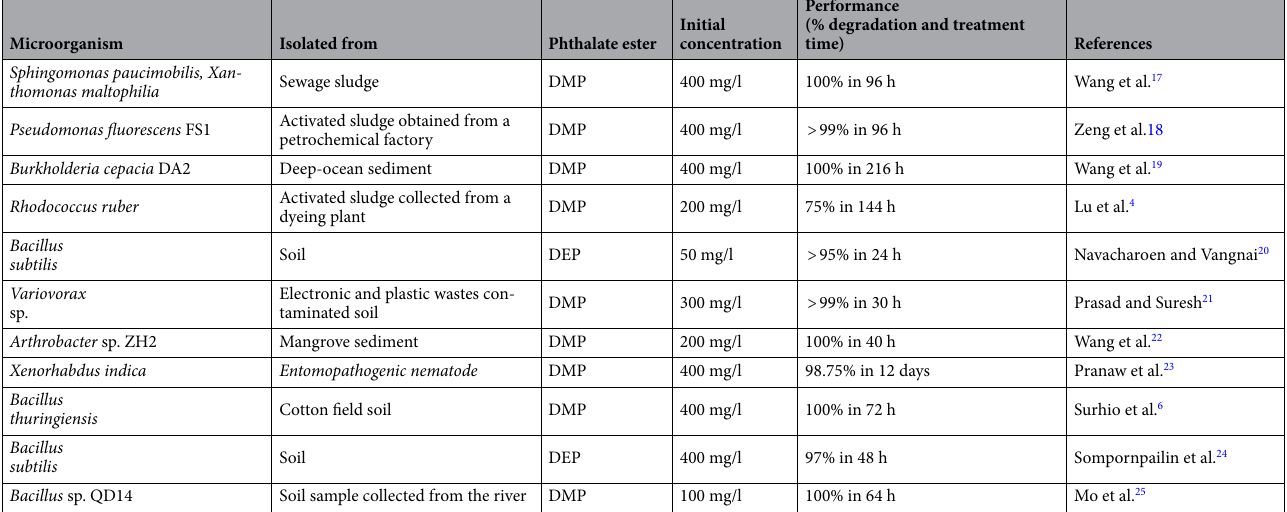
Table 1. Biodegradation studies dimethyl phthalate (DMP) reported in